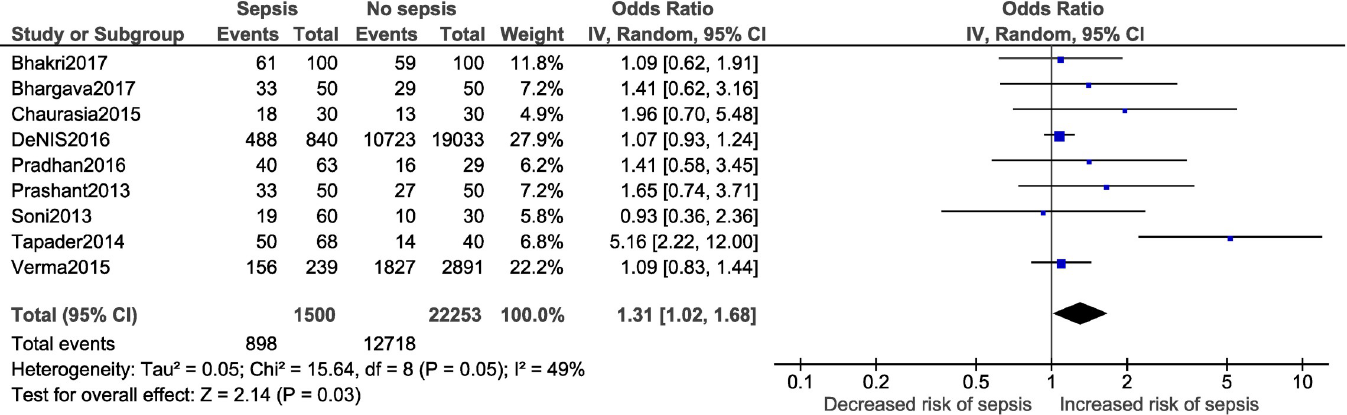
Fig 2. Forest plot showing a random-effects meta-analysis of male neonates with and without sepsis.